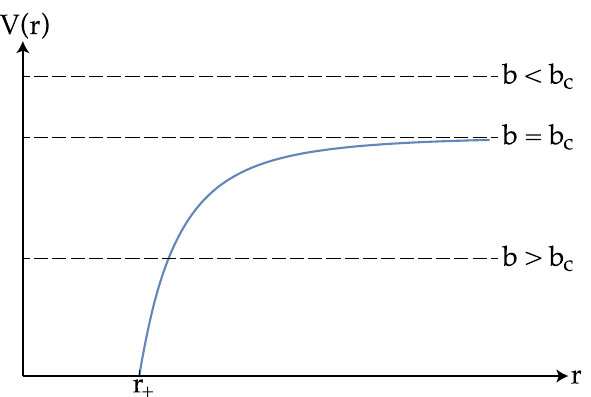
Fig. 1 Graphs of the topological toroidal effective potential as a func- tion of the radial coordinate. The critical impact parameter b c corre- sponds to the value of b at r →